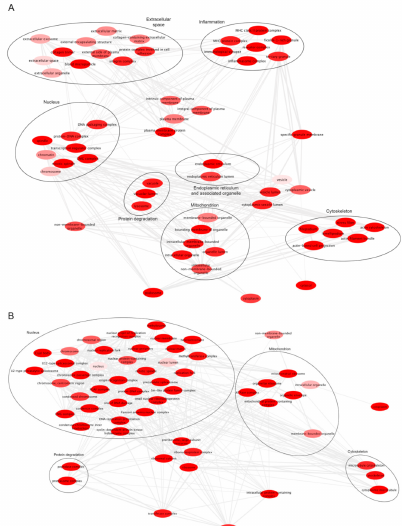
Figure 1. Enriched GO terms. ( A ). GO enrichment from upregulated genes in GB from GSE147352 dataset. ( B ). GO enrichment from upregulated genes in GB grade IV from GSE79878 dataset. The bubble color indicates the FDR for the GO term (bright red lower FDR). Highly similar GO terms are linked by edges in the